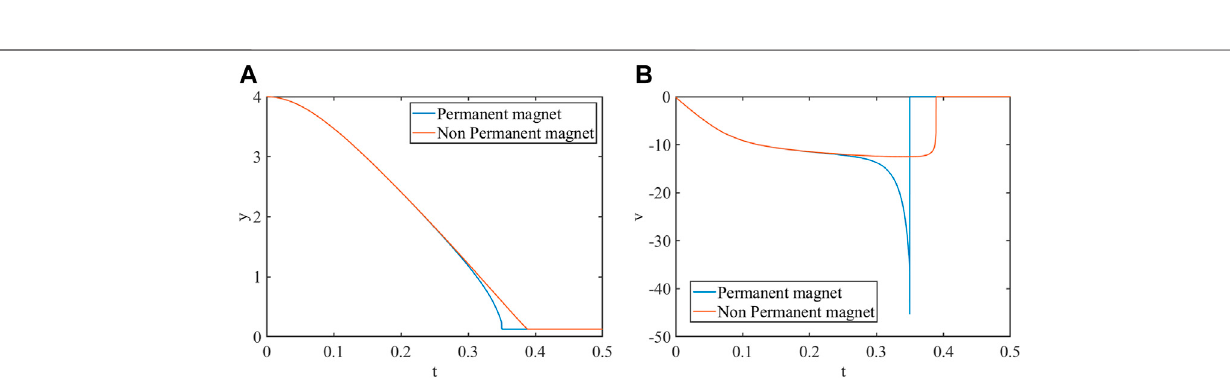
FIGURE 12 | Position (A) and velocity (B) of the center of the particle for ρ p (cid:2) 1 . 5 g / cm 2 and ] (cid:2) 0 . 01 cm 2 / s .